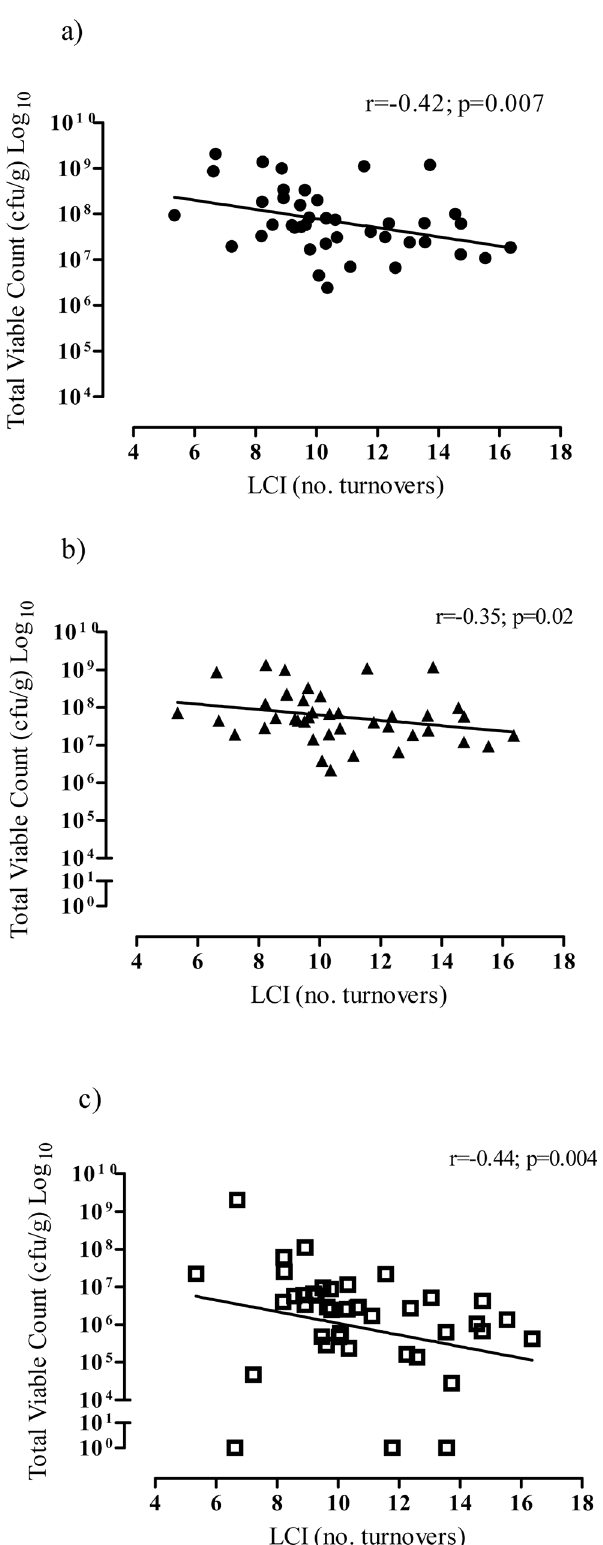
Fig 2. Relationship between LCI and a) total colony count b) aerobic colony count and c) anaerobic colony